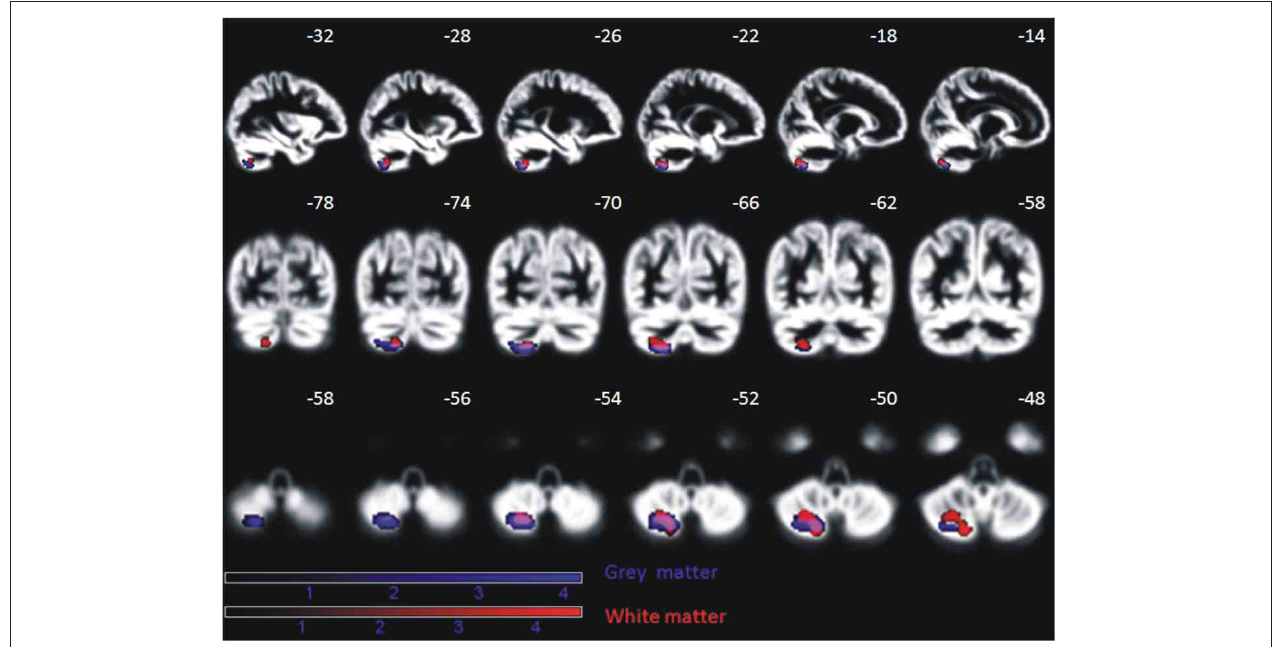
FIGURE 12 | Significant increase of gray and white matter in the posterior cerebellum of nine AMD patients over the period of oculomotor training for, on average, 6 months ( p < 0 . 05, FDR corrected on cluster level). This effect is absent in age-matched